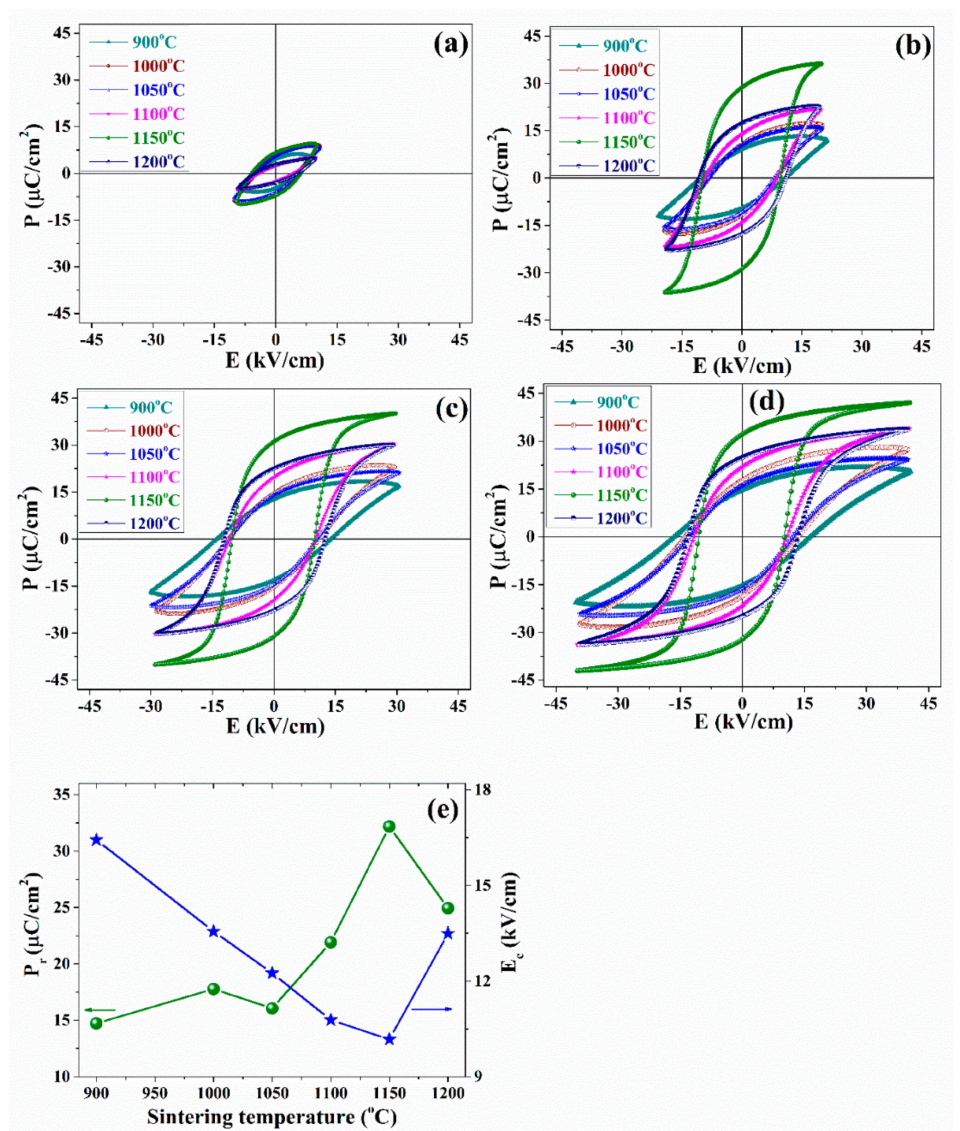
Figure 3. Evolution of polarization vs. electric field ( P-E ) hysteresis curves at an applied electric field of ( a ) 10 kV / cm, ( b ) 20 kV / cm, ( c ) 30 kV / cm and ( d ) 40 kV / cm respectively for the microwave sintered PLZT 8 / 60 / 40 unpoled ceramic sample at 1 Hz and 25 ◦ C. ( e ) Change in P r and E c as a function of microwave sintering temperature, measured at 40 kV /